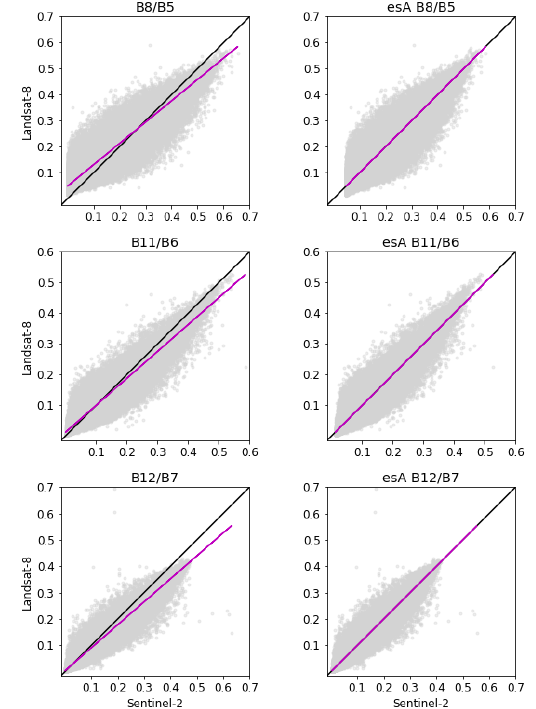
Figure A3. Comparison of surface reflectance values from the Sentinel-2 and Landsat-8 corresponding bands for Eastern Siberia. Left plots: observed surface reflectance values. Right plots: Eastern Siberia Adjusted (esA) Sentinel-2 reflectance values. The solid black line is one-to-one, and the pink line is the ordinary least squares regression trend line.